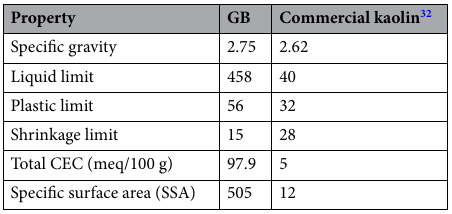
Table 1. Index and surface properties of the studied